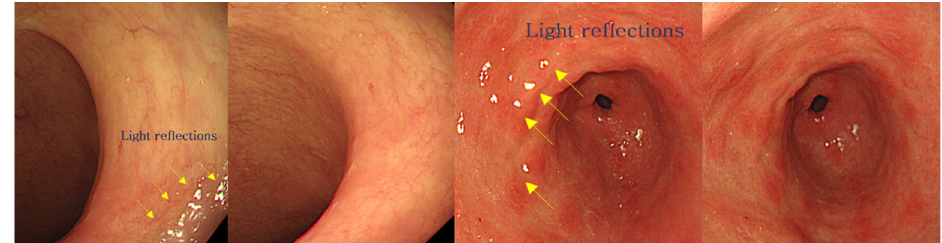
Figure 7. Comparison of images obtained before and after eliminating specular reflection during a colon endoscopy.